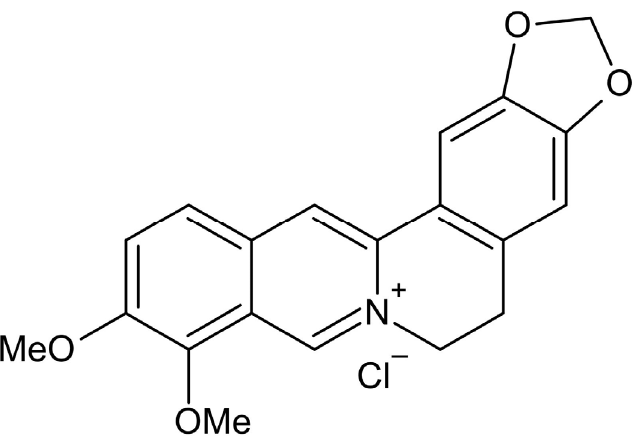
Figure 1. The structure of